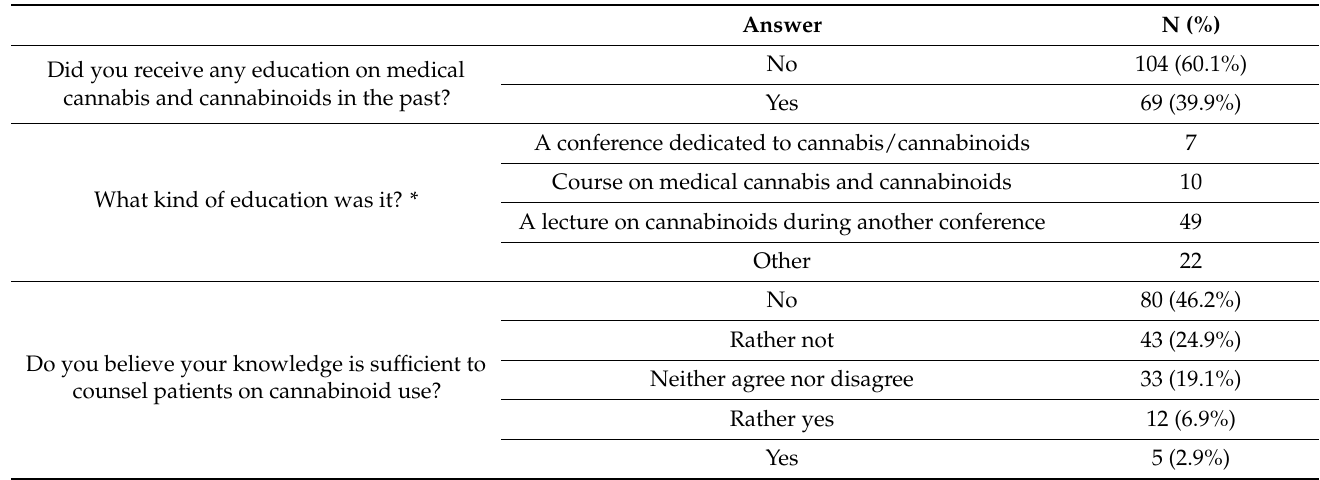
Table 2. Education on medical cannabis and